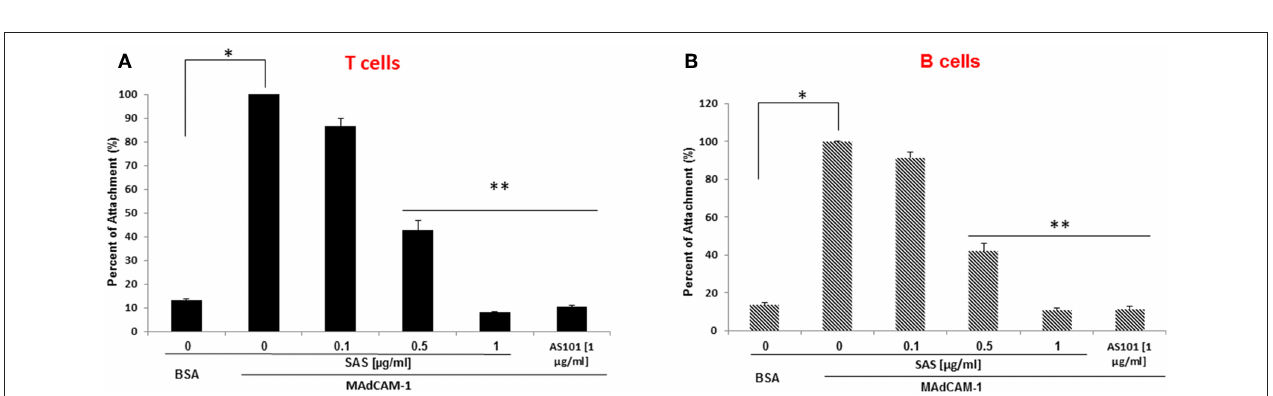
FIGURE 2 | AS101 and SAS inhibit in vitro the activity of the α 4 β 7 integrin in various organs of NOD mice. 5 × 10 5 single cells from spleens (A) , peripheral LN (B) , and PLN (C) from 10 week old NOD mice were cultured on BSA or MAdCAM-1-coated micro wells for 2h in the presence or absence of different concentrations of SAS or AS101The cells were washed twice and then subjected to XTT reagent according to the manufacturer’s instructions. The results represent means ± SE of three different experiments. * p < 0.001 decrease vs. MAdCAM-1 without AS101 or SAS (SAS 0).